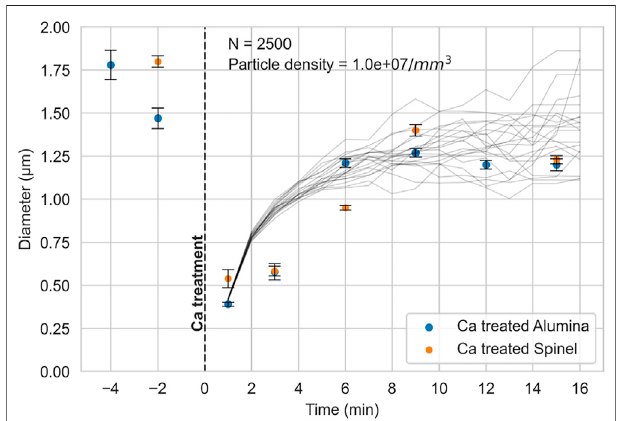
FIGURE7| Intervalplotofinclusionsizeforboth experiments. Theblack linesrepresenttheMonteCarlosimulationsofinclusiongrowthbycollision,for conditions as indicated in the